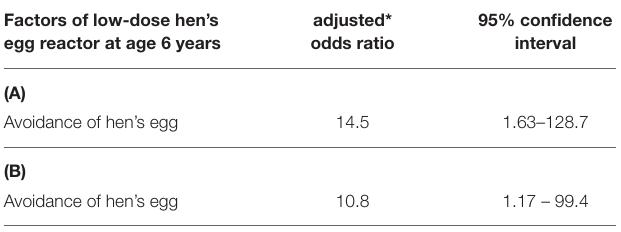
TABLE 2 | Multiple logistic regression models: Adjusted Odds of low-dose hen’s egg reactor at age 6 years. (A) avoidance of HE and ovomucoid-specific IgE levels at < 2 years of age, (B) peak egg white IgE levels > 50 UA/ml and avoidance of hen’s